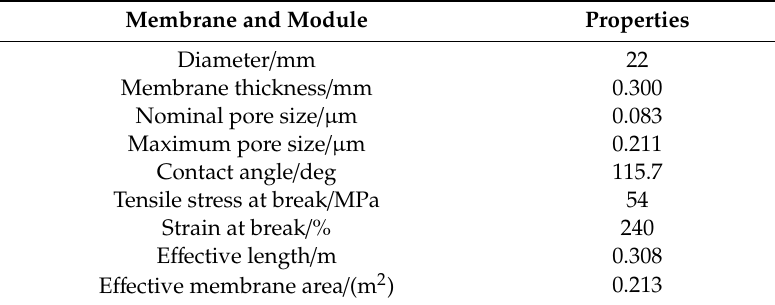
Table 3. Parameters of membrane material and